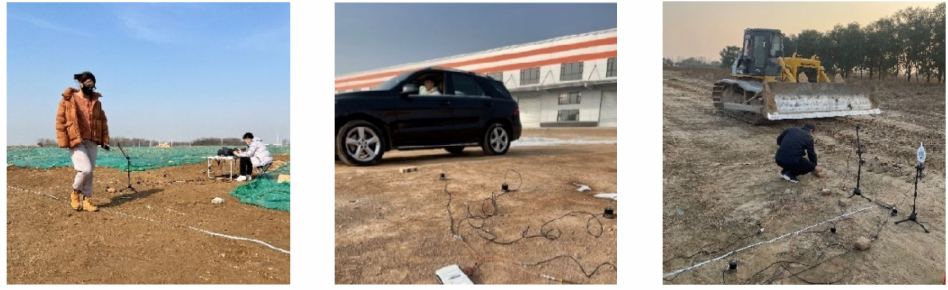
Figure 10. Outdoor experiment setup.